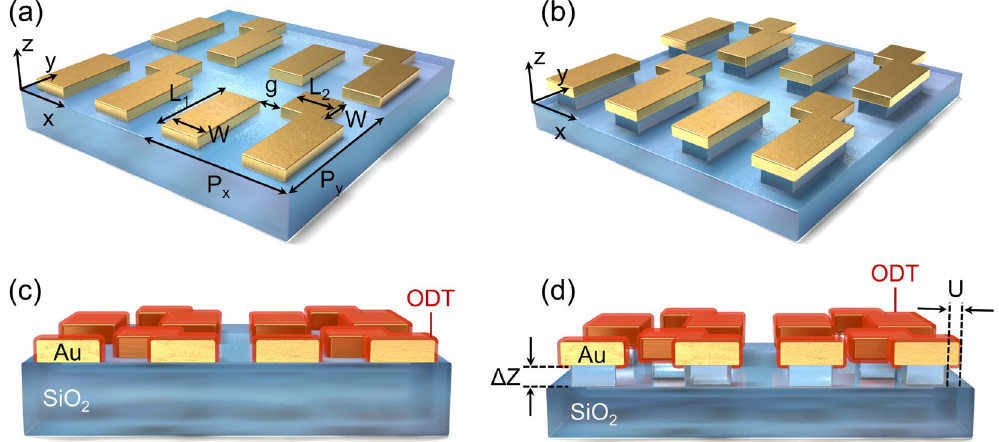
Figure 1. Schematics of the control FMM structure ( a ) and the FMM on the nanopedestal structure. ( b ) The dimensions of the FMM structure are: P x = 1600 nm, P y = 1600 nm, L 1 = 680, 740, and 800 nm, L 2 = L 1 /2, g = 200 nm, and W = 300 nm. Cross-sectional views of the control FMM ( c ) and the FMM on the nanopedestal ( d ) with ODT monolayer coated around the Au nanoantennas are also shown. The undercut etching depth (U) of the FMM on the nanopedestal structure is 30 nm and the vertical etching depth ( Δ Z) is 50